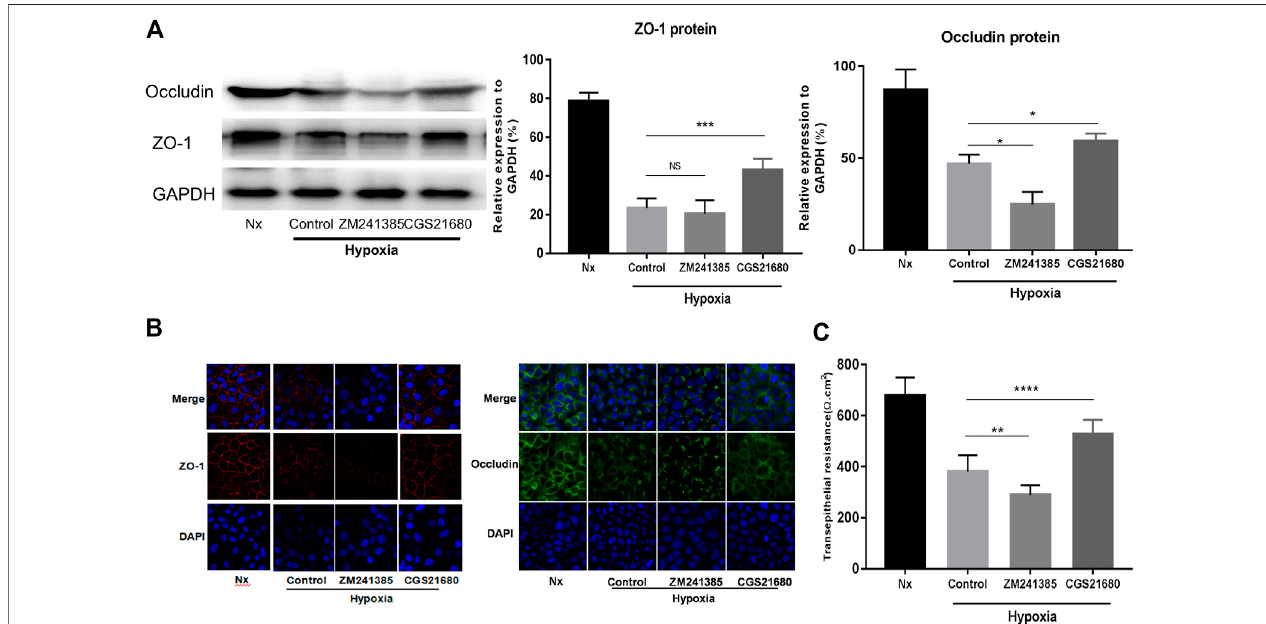
FIGURE2| ActivationofA 2A Rinentericglialcells(EGCs)preventsCaco-2monolayerbarrierdysfunctionunderhypoxiastimulation. (A – C) EGCswereco-cultured with Caco-2 monolayers for 24 h and then treated with ZM241385 (1 μ M) and CGS21680 (100 nM) for 6 h respectively under hypoxia conditions. (A) Western blot and (B) immuno fl uorescence analyses were used to detect ZO-1 and occludin expression. (C) The transepithelial electrical resistance (TER) of Caco-2 monolayers was determinedtoevaluateintestinalepithelialbarrier (IEB) function. Results areexpressed asmean ± SD.(** p < 0.01; *** p < 0.001;**** p < 0.0001;NS, notsigni fi